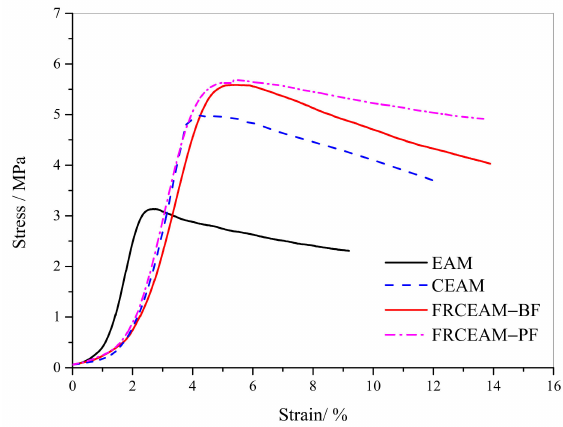
Figure 3. Complete CSS curves of CEAM and